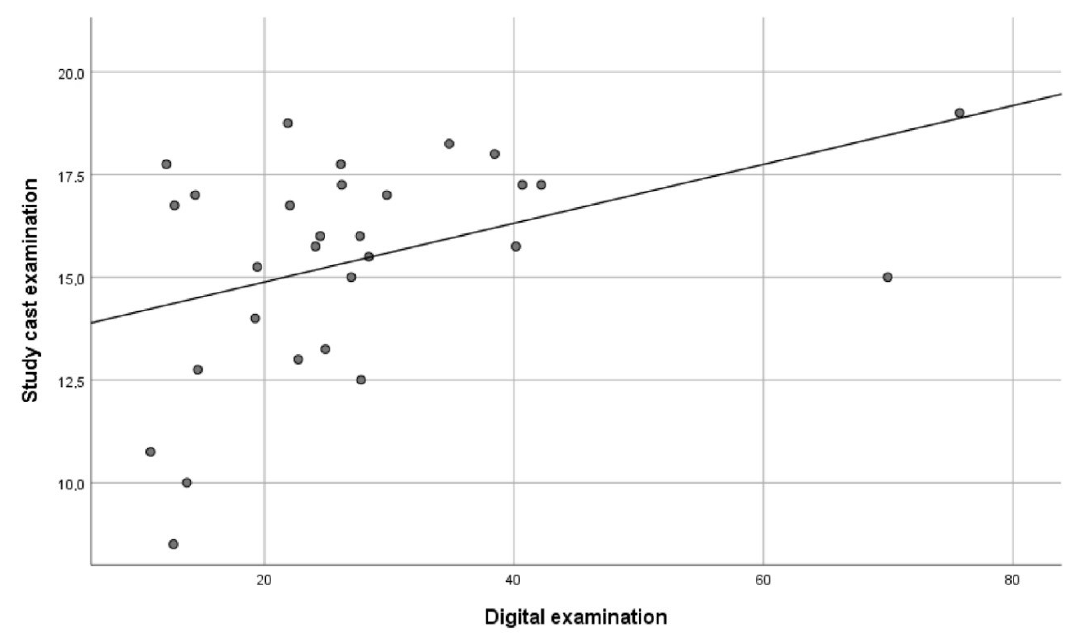
Figure 4. Scatterplot explaining the relationship between the total amount of occlusal contacts in the study cast examination and the total occlusal contact area in mm 2 in the digital examination ( n = 29). Every dot represents one of the included participants ( p < 0.05).